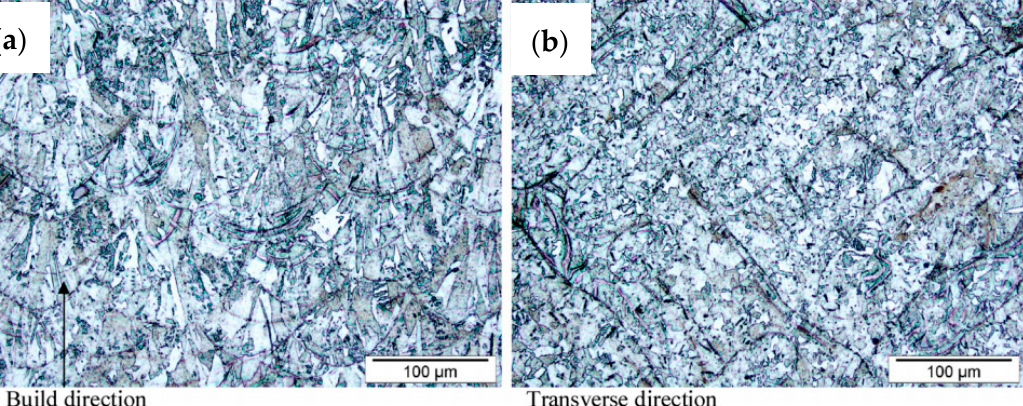
Figure 11. OM showing L-PBF 304 stainless steel microstructure: ( a ) along the vertical cross-section— the heat flow effect is evident in the build direction, and ( b ) nearly equiaxed grains in the planar direction, coincident to the layer top view. From [127], with permission from Elsevier, 2019.